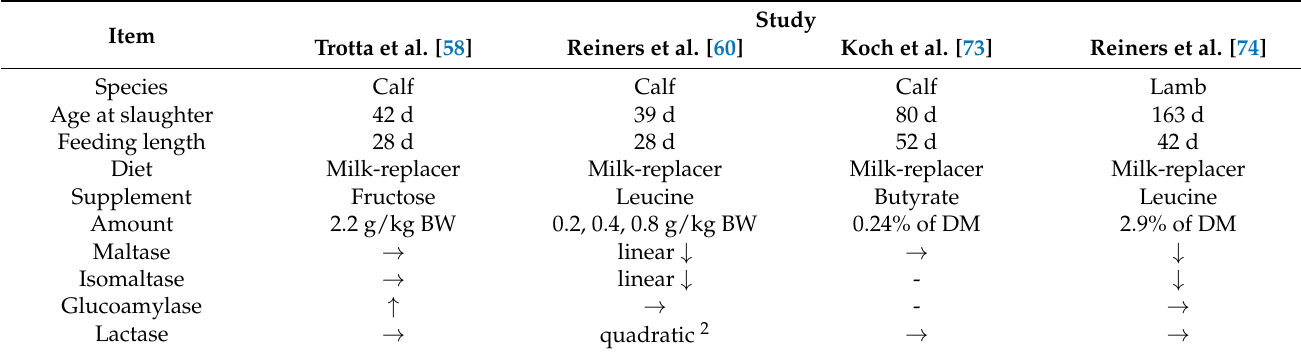
Table 1. Selected studies evaluating the effects of dietary supplementation to neonatal calves or lambs on small intestinal carbohydrase activities 1